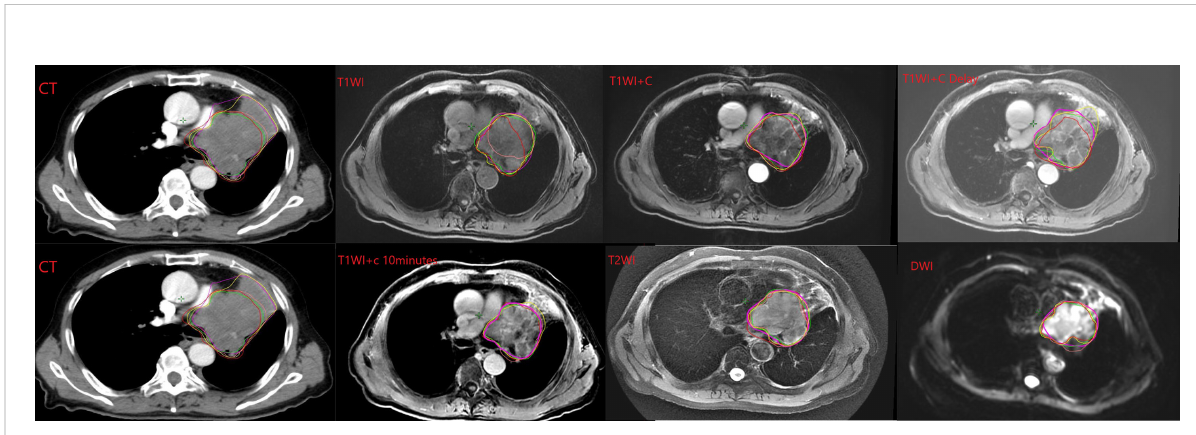
FIGURE 1 Example of GTV contoured on the different CT and MRI sequences by each observer. Note: The lines of different colors in the picture represent different